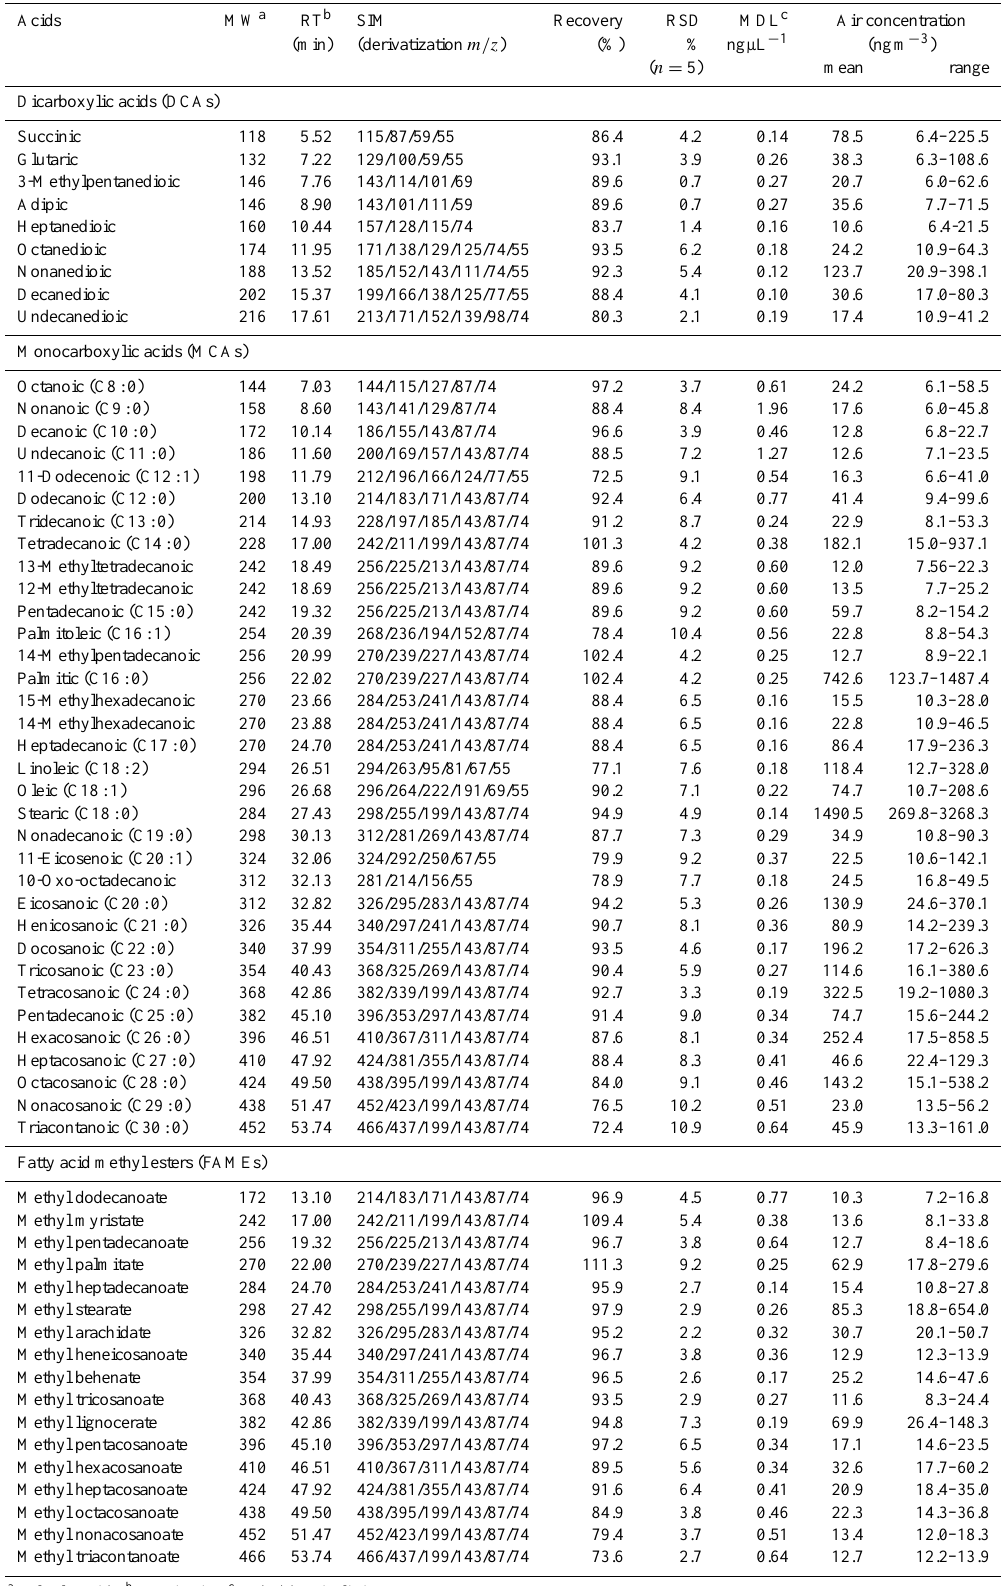
Table 1. Parameters used to determine organic acids, FAMEs, and the concentrations found in samples collected in January 2013,